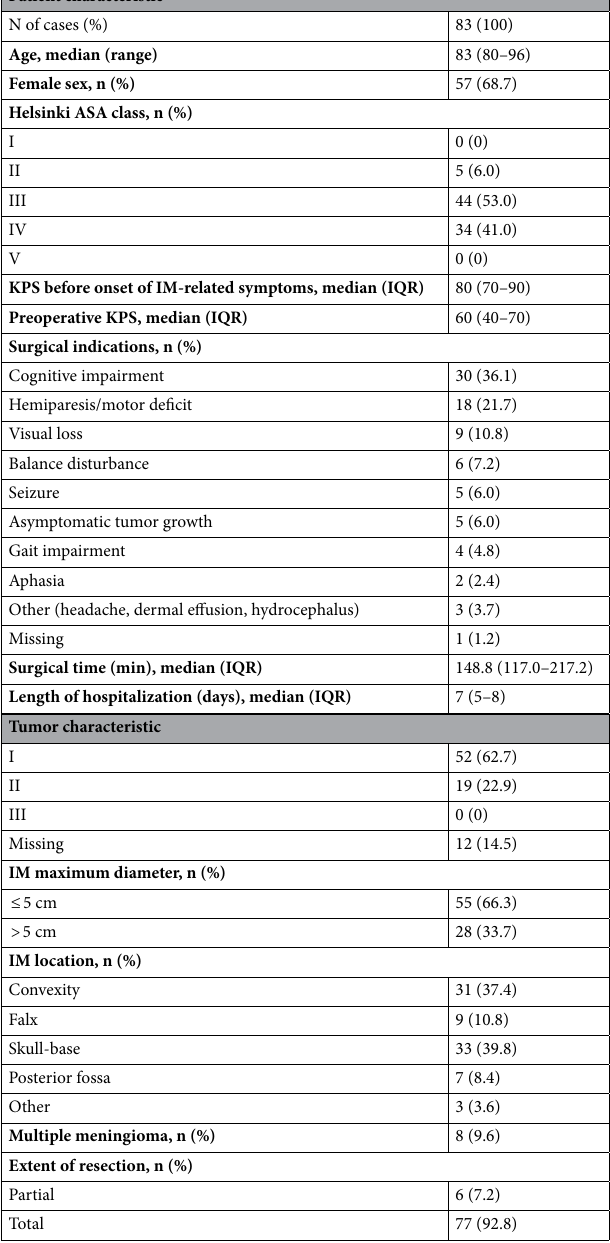
Table 1. Patient and tumor characteristics. ASA American Society of Anesthesiologist; IM intracranial meningioma; IQR interquartile range; KPS Karnofsky Performance Status; WHO World Health